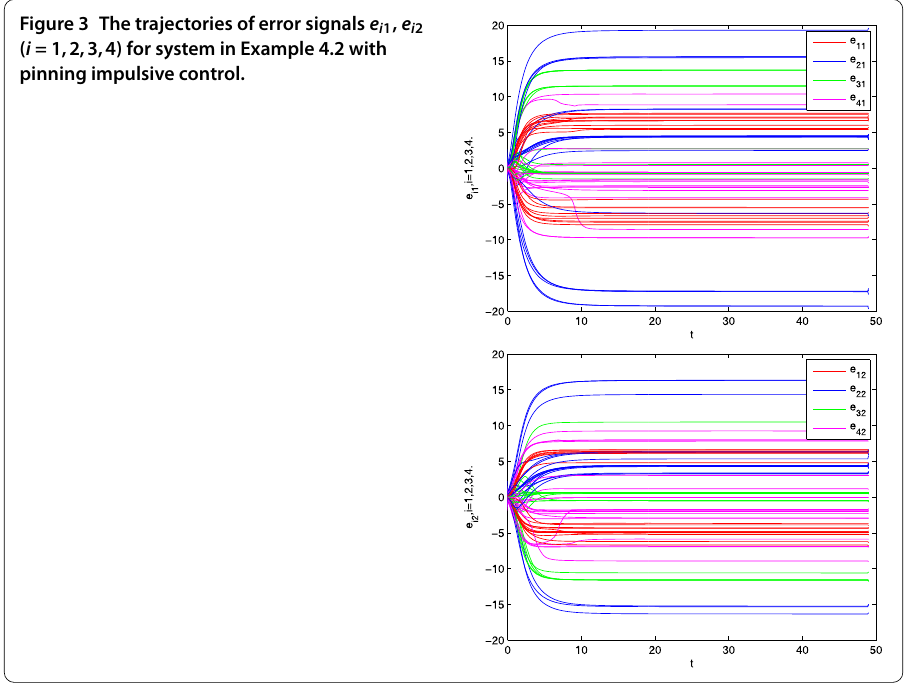
pinning impulsive